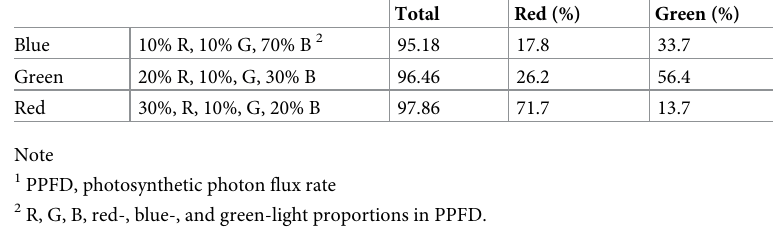
root morphology. Six were randomly chosen and measured for leaf attributes and dry biomass using dried samples. Others were used to measure chlorophyll and leaf protein contents. Sam- ples were oven-dried at 70˚C for 72 h and used to quantify dry weight [9, 35]. After passing 1-mm sieves, dried samples were ground and used to determine N and P concentrations. A 0.2-g sample was digested in sulfuric acid, diluted, and analyzed by the Kjeldahl method. P concentration was measured using Inductively Coupled Plasma Optical Emission Spectrome- try (Thermo Fisher Scientific, Waltham, MA, USA) [36]. Quality was evaluated by the classic model [37]: